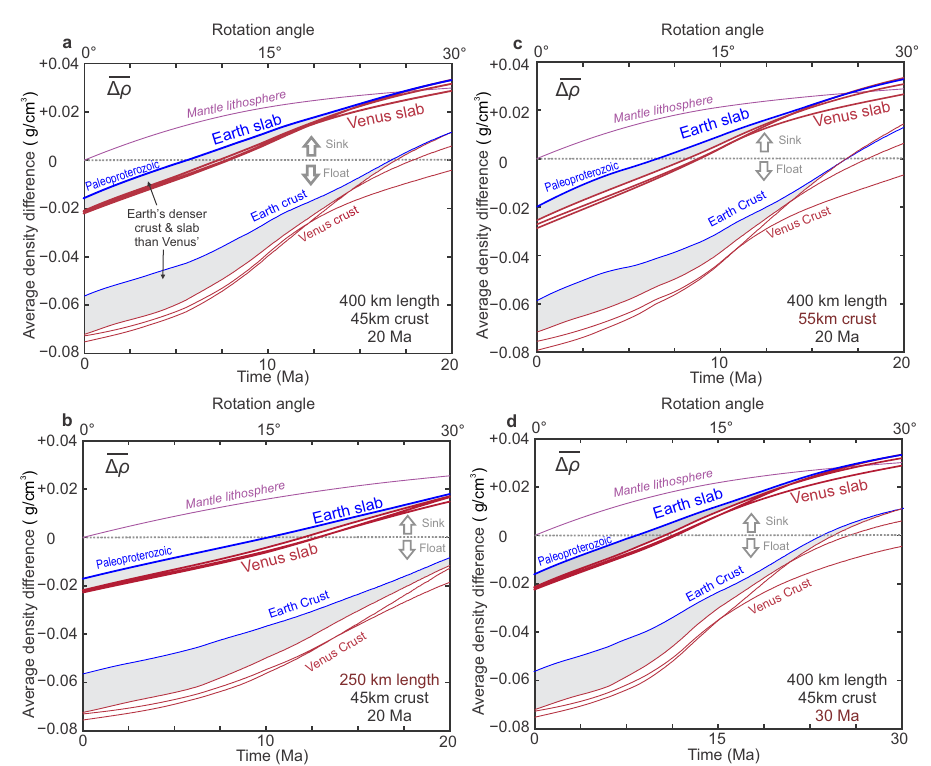
Fig. 4 | Average density differences between ambient mantle and slab in var- iousmodelsettings.a ThemodelsettingasFig.1b.400kmlongslab,45kmcrust, 105km thick mantle lithosphere slab, subducted to 30° in 20Ma. b 250km long